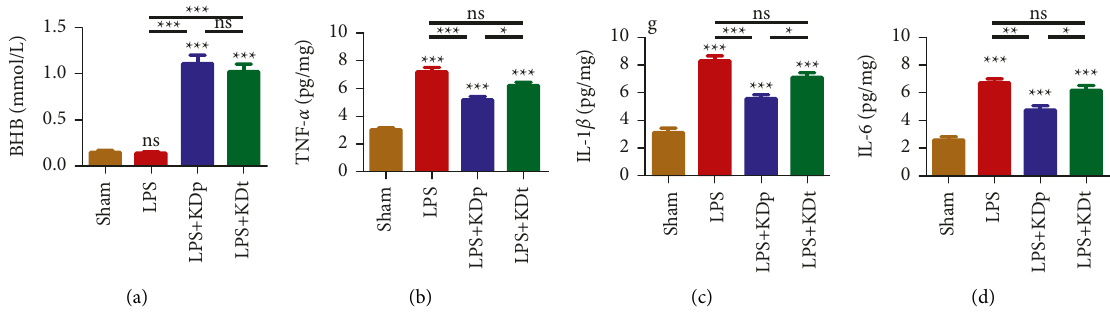
Figure 3: Effects of LPS and KD on the serum BHB level and the production of pro-inflammatory mediators in SN. The level of serum BHB (a), TNF- α (b), IL-1 β (c) and IL-6 (d) were compared among multiple groups. Data were presented as the mean ± SEM. ∗∗∗ P < 0 . 001; ∗∗ P < 0 . 01; ∗ P < 0 . 05; LPS, lipopolysaccharide; KDp, preventive intervention with KD prior to the PD onset; KDt, therapeutic intervention with KD after the PD onset.